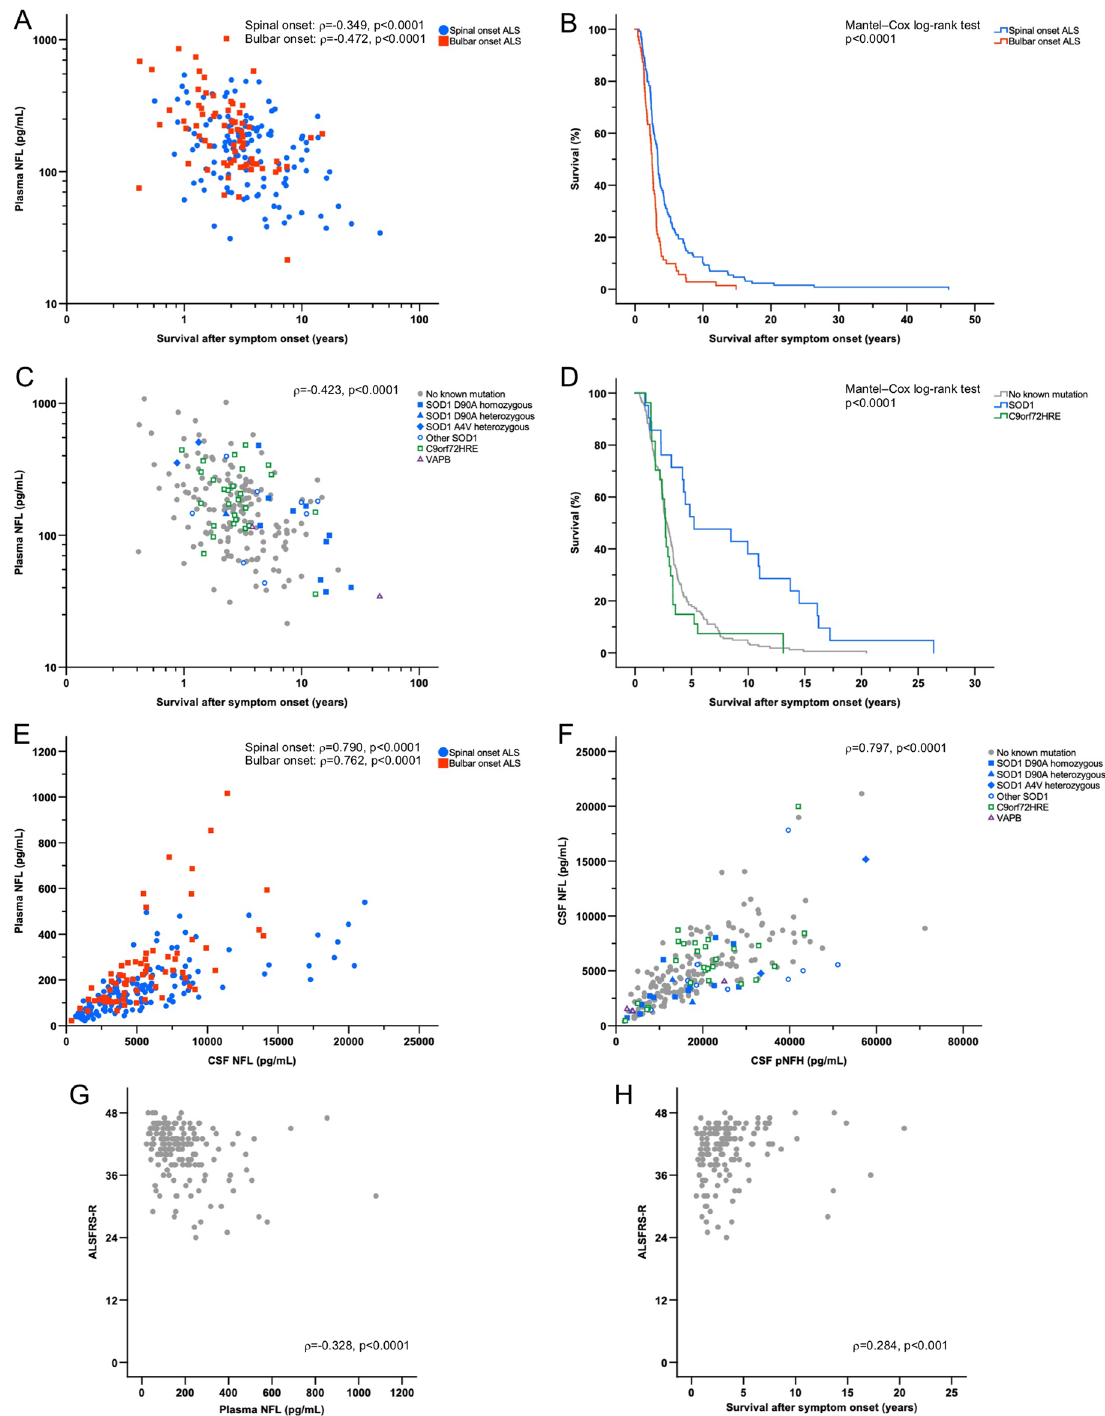
Figure 3. Biomarker correlation to survival, survival analyses in clinical symptom onset and genotype groups, biomarker ratios and ALSFRS-R in ALS patients. (A) Correlation between plasma NFL and survival after symptom onset stratified by spinal and bulbar symptom onset. (B) Kaplan–Meier survival analysis for spinal onset versus bulbar onset ALS patients. (C) Correlation between plasma NFL and survival after symptom onset for participants in the total ALS cohort. (D) Kaplan–Meier survival analysis between patients with no known mutation, SOD1 mutation and C9orf72HRE mutation ( p -value presented for overall comparisons). (E) Ratios and correlations between plasma NFL and CSF NFL stratified for spinal onset and bulbar onset ALS patients. (F) Correlation between CSF NFL and CSF pNFH for participants in the total ALS cohort. (G) Correlation between ALSFRS-R and plasma NFL in ALS patients. (H) Correlation between ALSFRS-R and survival after symptom onset in ALS